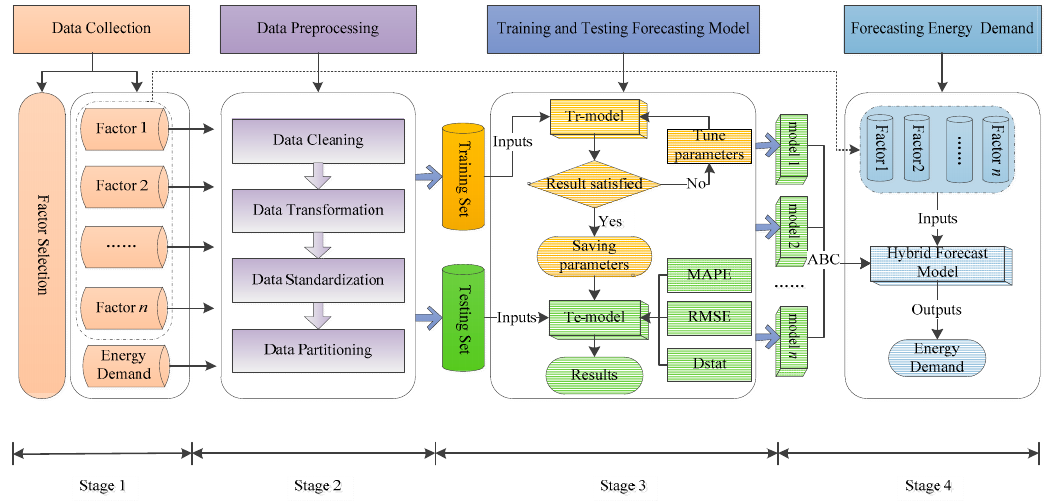
Figure 1. Ensemble framework of energy demand forecast.